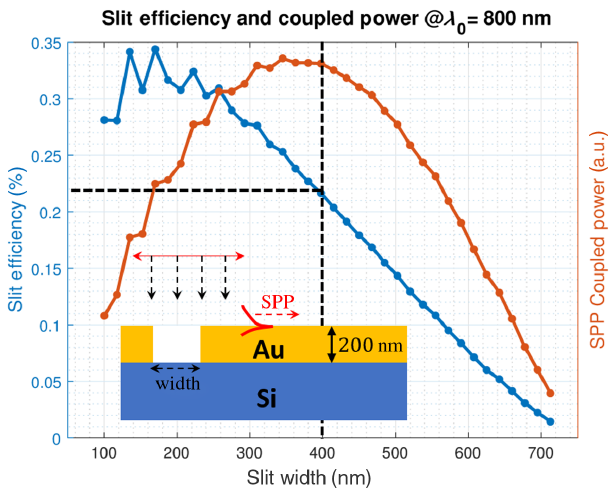
FIG. 6. Modeling of the coupling efficiency of a rectangular slit milled in gold on a silicon substrate under illumination by a horizontally polarized plane wave at normal incidence (red arrow for polarization and dashed black for propagation direction). The red schematic in the inset is the SPP field profile propagating on the gold-air interface. The blue curve represents the intrinsic slit coupling efficiency with the coupled power normalized by the area (width) of the slit relative to the area of the source (fill factor). The orange curve represents the power coupled to the SPPs in arbitrary units. The dashed black curves mark our condition slit width of 400 nm, resulting in an efficiency of 22% and roughly maximal coupling power.